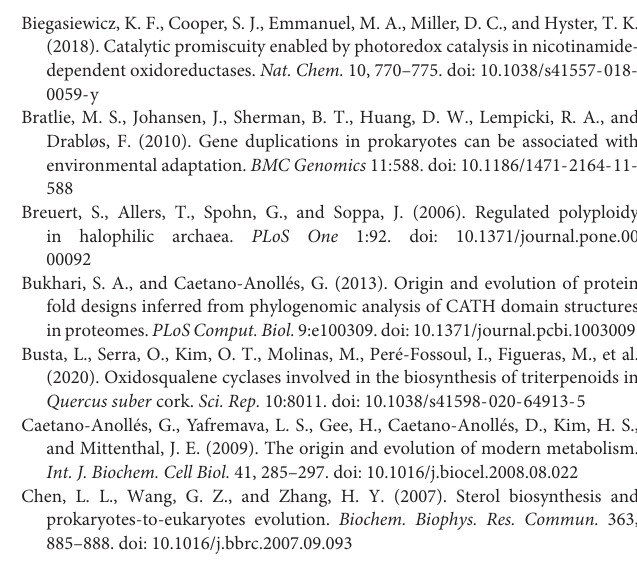
Supplementary Figure 5 | Comparison of the ratio of paralogous enzymes across the different lifestyles. (A) The ratio for each organism is plotted together with its number of proteins and enzymes. Each of the four colors represents organisms from the same lifestyle. The diameter of each point of the plot is proportional to the ratio of paralogous enzymes, as indicated in the right part of the figure. (B) Notched box plots for the average ratio of paralogous enzymes for the organisms grouped by its lifestyle. Graphically, the ratio value differs significantly in all cases because the notches never overlap each other. Supplementary Figure 6 | Number of paralogous enzymes found within prokaryotic oxidoreductases (A) , isomerases (B) , and translocases (C) subclasses. Each cell of the heatmaps represents the mean value of the phylum for that specific subclass. The values were scaled for each column using the formula z = ( x − u )/ s , where x is the unscaled value, u is the mean of each column, and s is the column’s standard